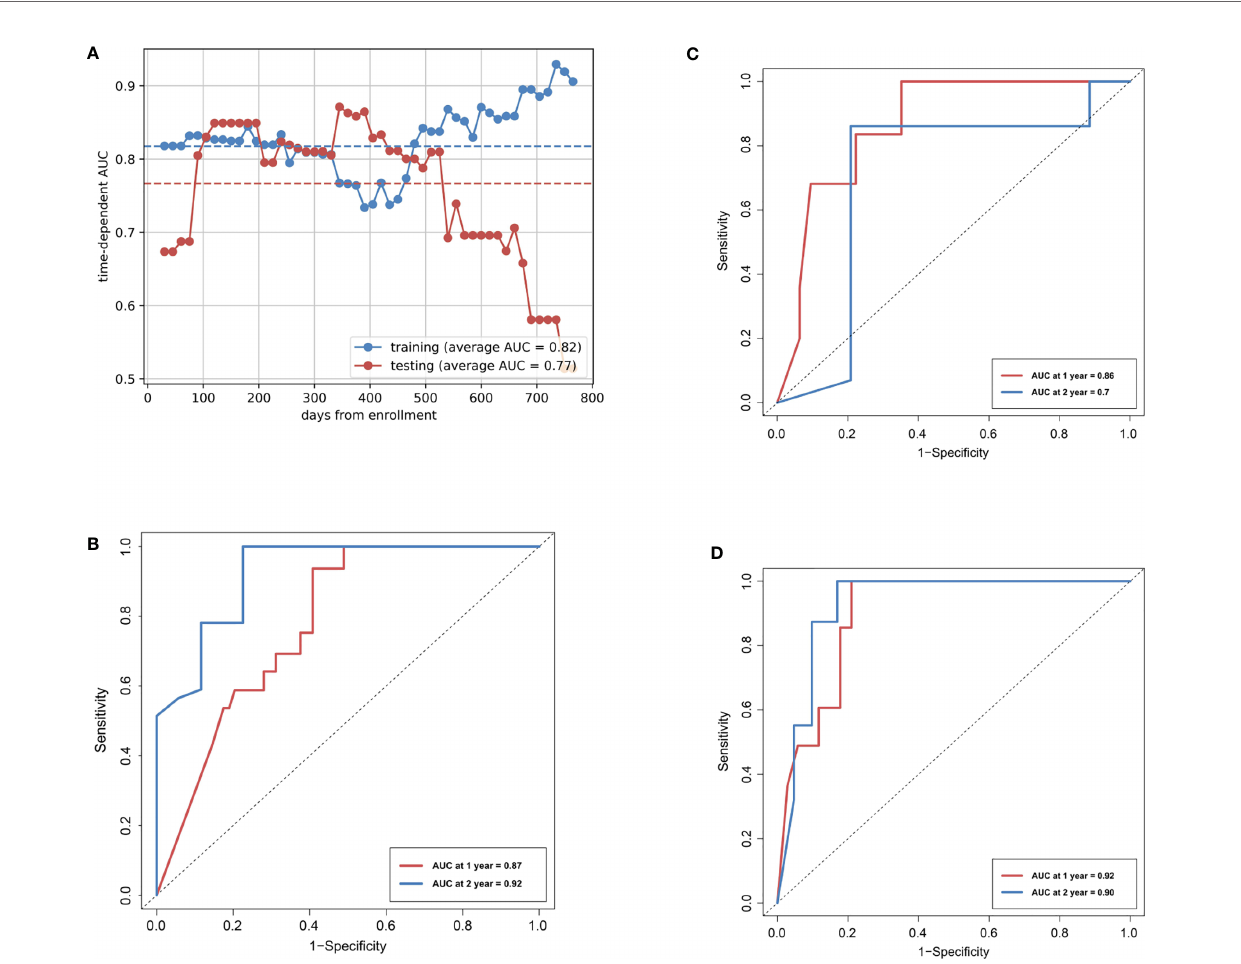
FIGURE 3 | Area under the receiver operating characteristic curves (AUCs) of R-model. (A) AUCs of Rad-score over time in the training and internal validation cohorts. (B) Time-dependent ROCs in the training cohort. (C) Time-dependent ROCs in the internal test cohort. (D) Time-dependent ROCs in the external test